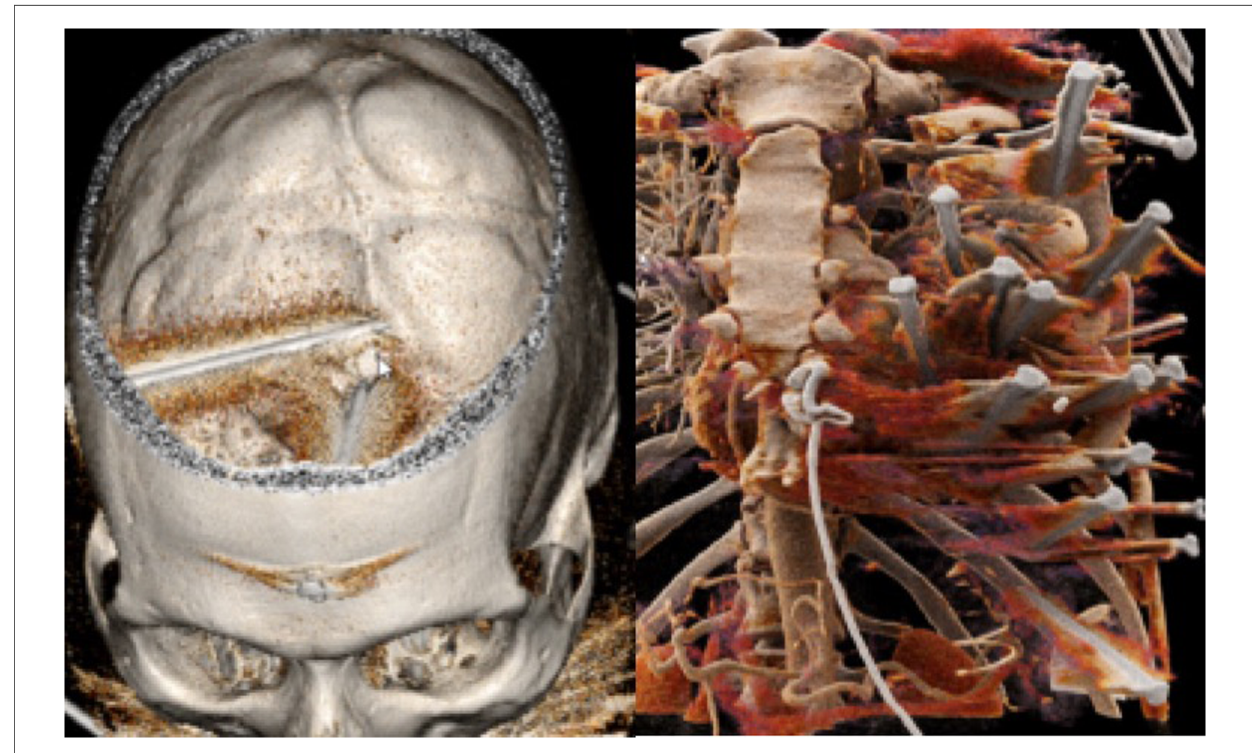
FIGURE 2 3d reconstruction of the CT-scan showing nails in the head (left) and those penetrating into the heart, the left lung and the stomach